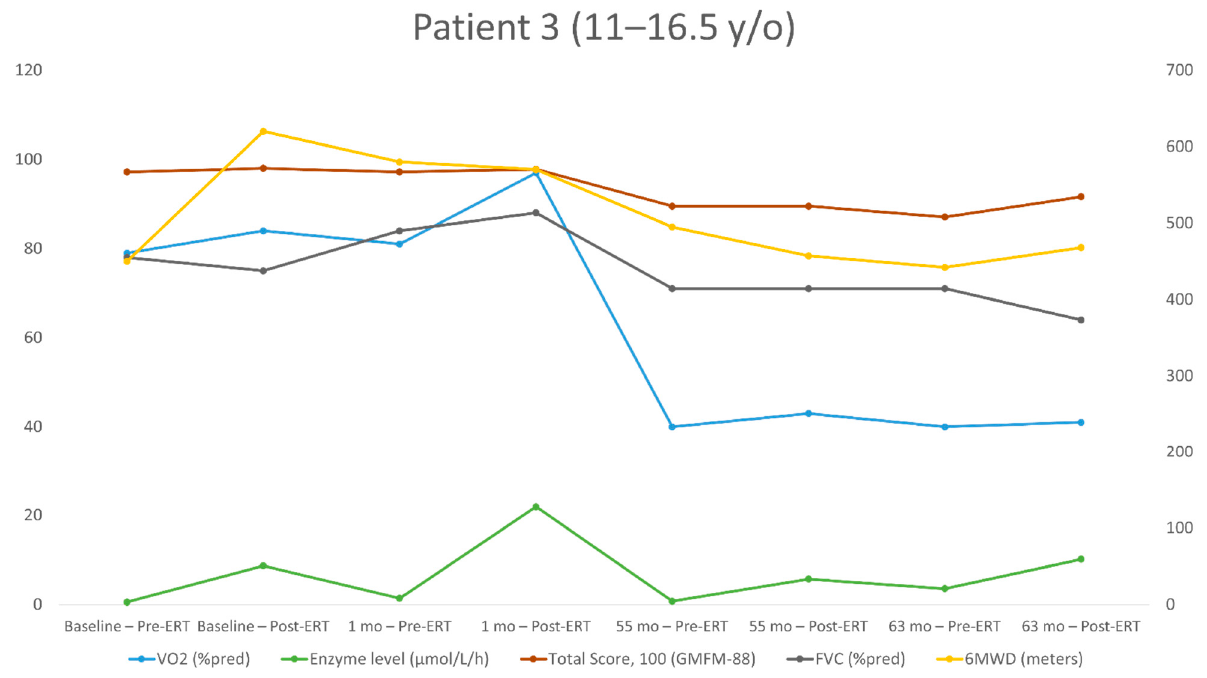
Figure 3. Long-term follow-up of the study parameters (patient 3). y/o = year old; VO 2 = peak oxygen uptake at the peak of exercise; %pred = % of the predicted value; FVC = forced vital capacity; 6MWD = 6-min walking distance.